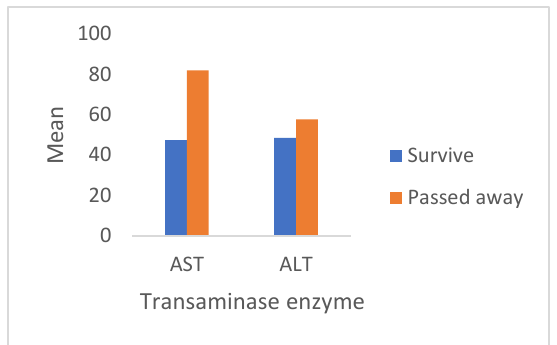
Figure 2. Transaminase level in surviving and passed away COVID-19 patients D I S C U S S I O N